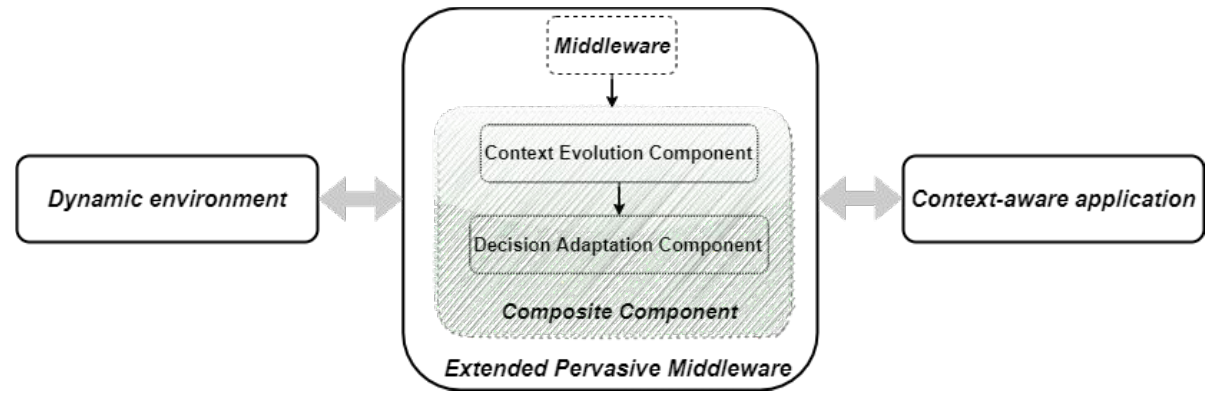
Figure 1. Architecture overview of the global approach